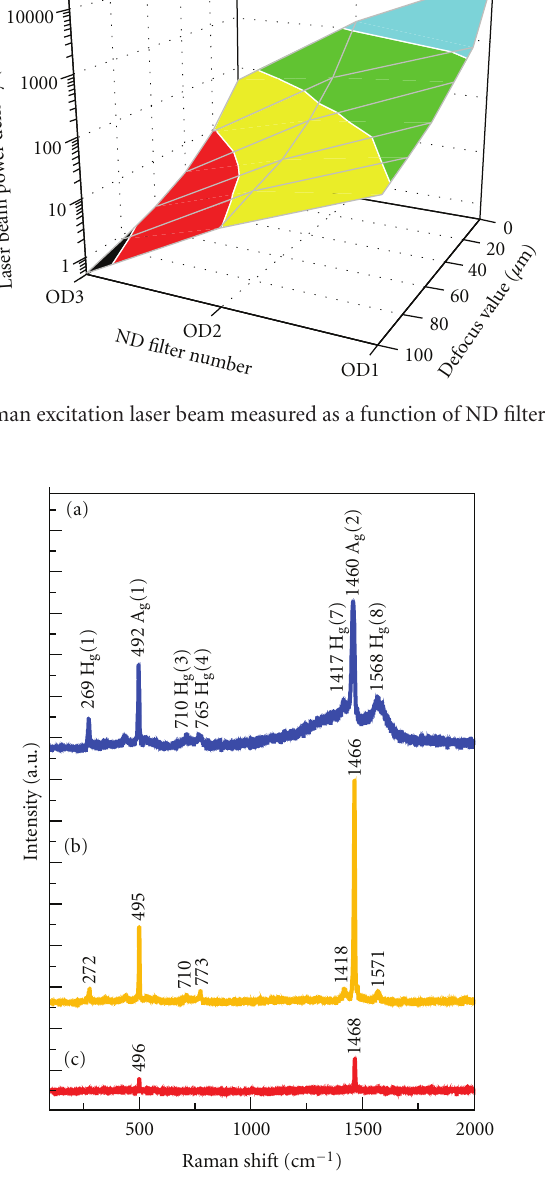
the red arrows for the high energy doses in Figures 6(c), 6(d), 6(e), and 6(f). These phenomena are supposed to be explained by the temperature rise of the C 60 NWs exposed to the laser beams, since it is known that the photopolymerized C 60 molecules decompose into their primary monomers and dimers by heating at temperatures higher than about 100 ◦ C [13]. The data points obtained using the highest power densities are indicated in each graph of Figure 6 by the black arrows for the exposure time of about 220 s. Figure 7 shows the relationship between the laser beam energy dose